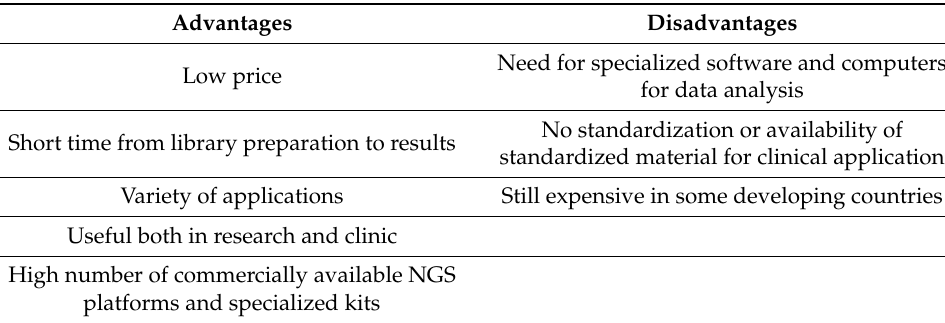
Table 1. Advantages and disadvantages of NGS